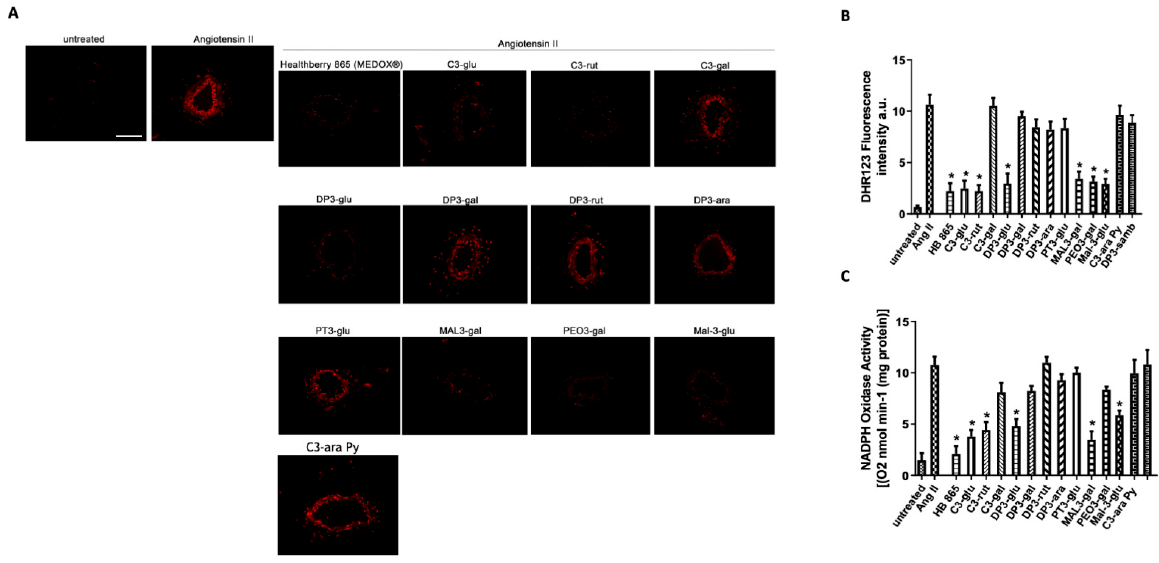
Figure 6. ( A ) Representative high-power micrographs of 10 µ m sections of mice mesenteric arteries loaded with a dihy- droethidium probe at the concentration of 5 µ M. Vessels were pre-treated with single anthocyanins (50 µ g/mL) for 1 h and then stimulated with angiotensin II for 15 min prior to the acquisition. Scale bar: 100 µ m. ( B ) Measurement of ROS production by DHR123 in vessels treated with single anthocyanins ( N = 4). ( C ) NADPH oxidase activity in mesenteric arteries exposed to HB or single anthocyanins ( N = 4). Data are expressed as increase of chemiluminescence per minute. * p <